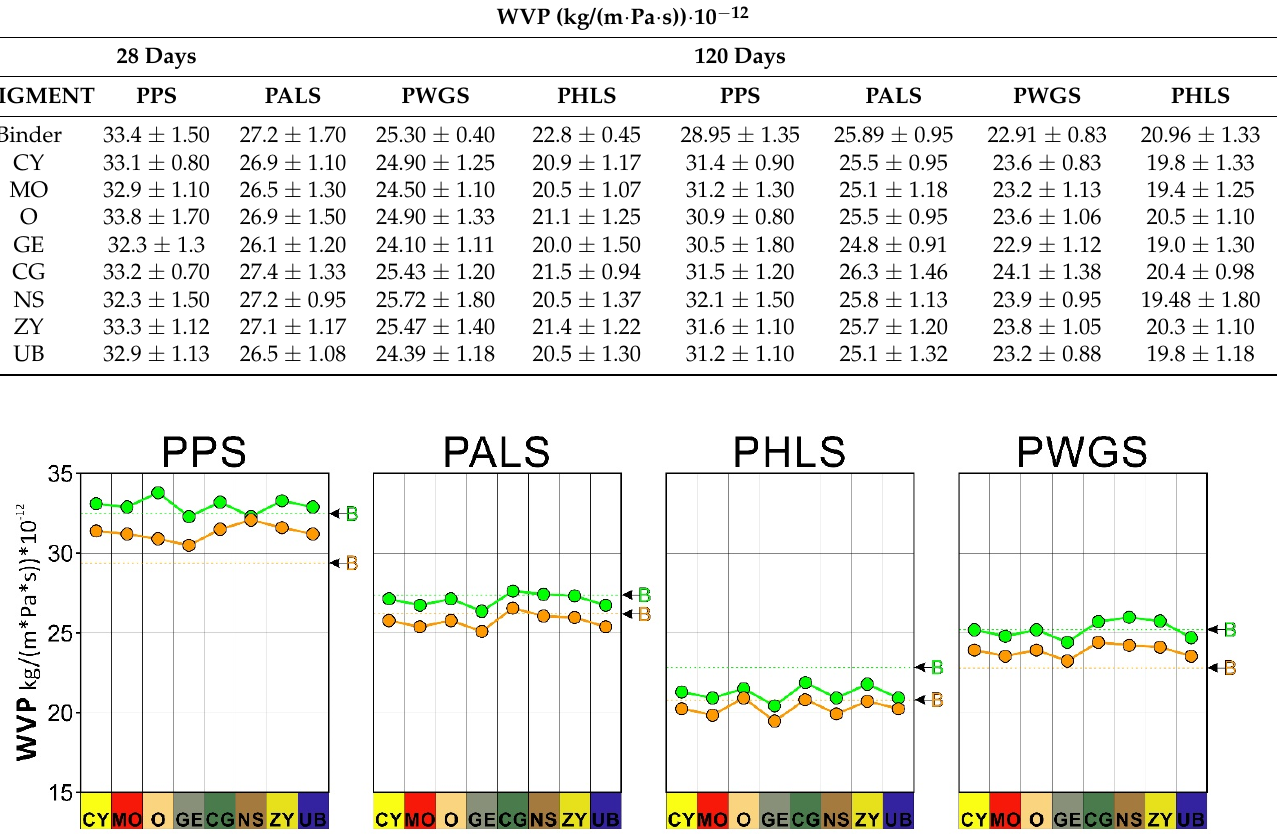
Table 5. Results of the water vapor permeability test and standard deviation for the different white pastes tested.